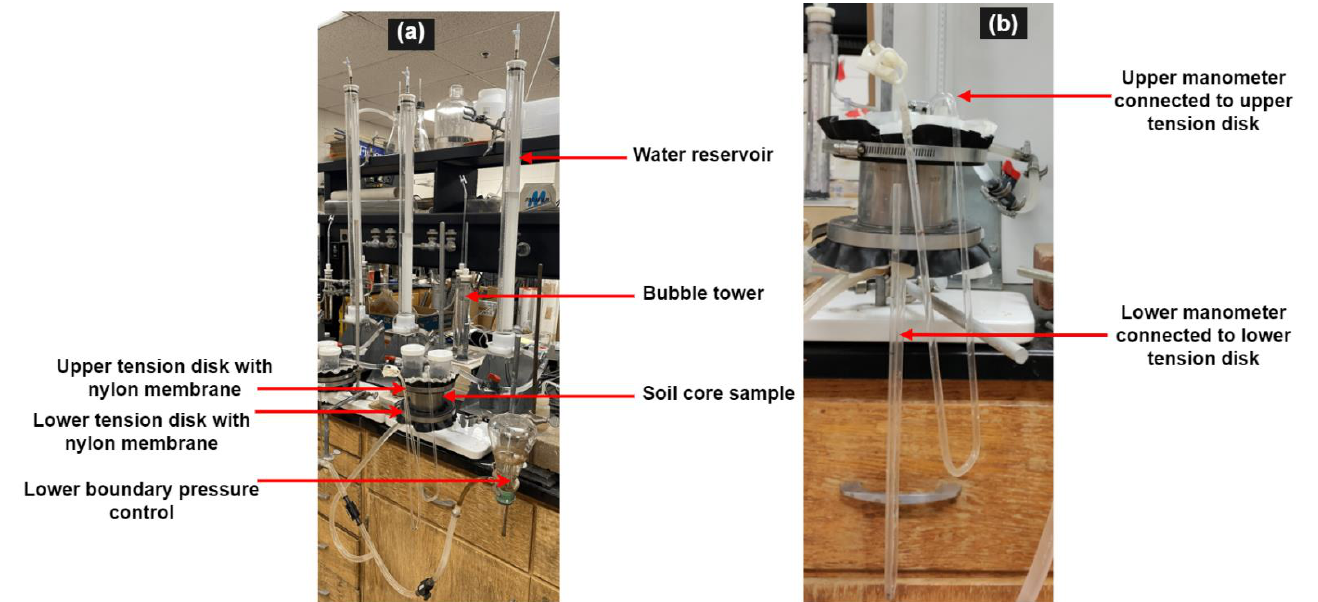
Figure 2. Image of the experimental set-up for the double membrane tension infiltrometer method located in soil physics laboratory of the Kentucky Agricultural Experiment Station, University of Kentucky, Lexington. ( a ) shows the complete set while ( b ) shows clearer view of the upper and lower manometers connected to the upper and lower tension disks respectively.